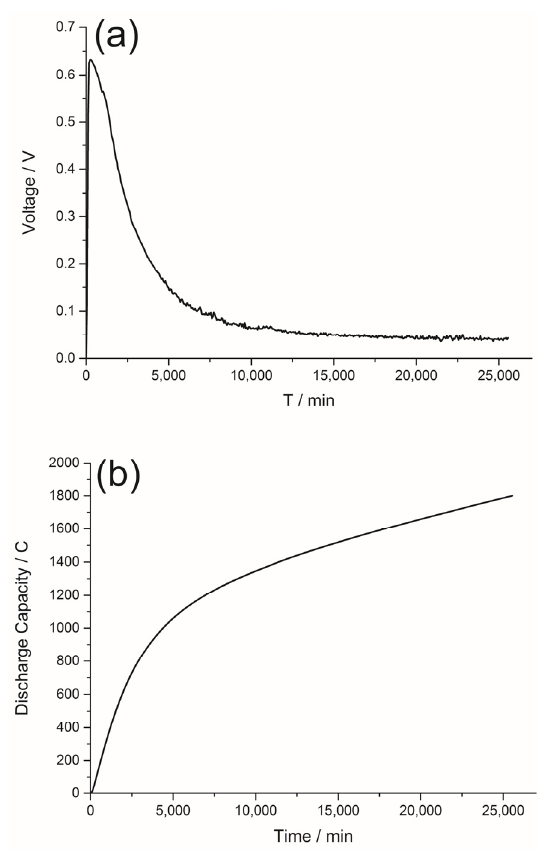
Figure 6. Curves of voltage versus time ( a ) and discharge curves ( b ) of the DGAFC under the condition of 1 M glucose, 3 M KOH.